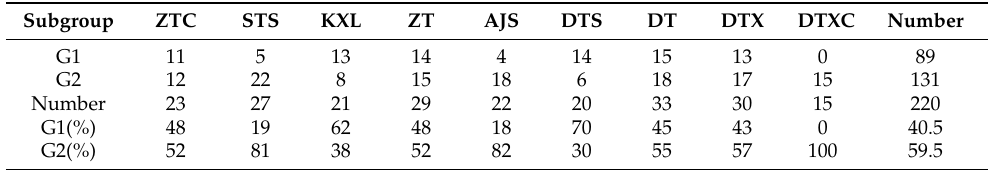
Figure 6. F ST of the two variation types of two subpopulations in DXWR, cultivated rice and other common wild rice. Cultivar: cultivated rice; Other WR: other common wild rice; DXWR G1: G1 Table 3. The distribution of the original population in nuclear genome resequencing grouping subpopulations of DXWR; DXWR G2: G2 subpopulations of DXWR. of